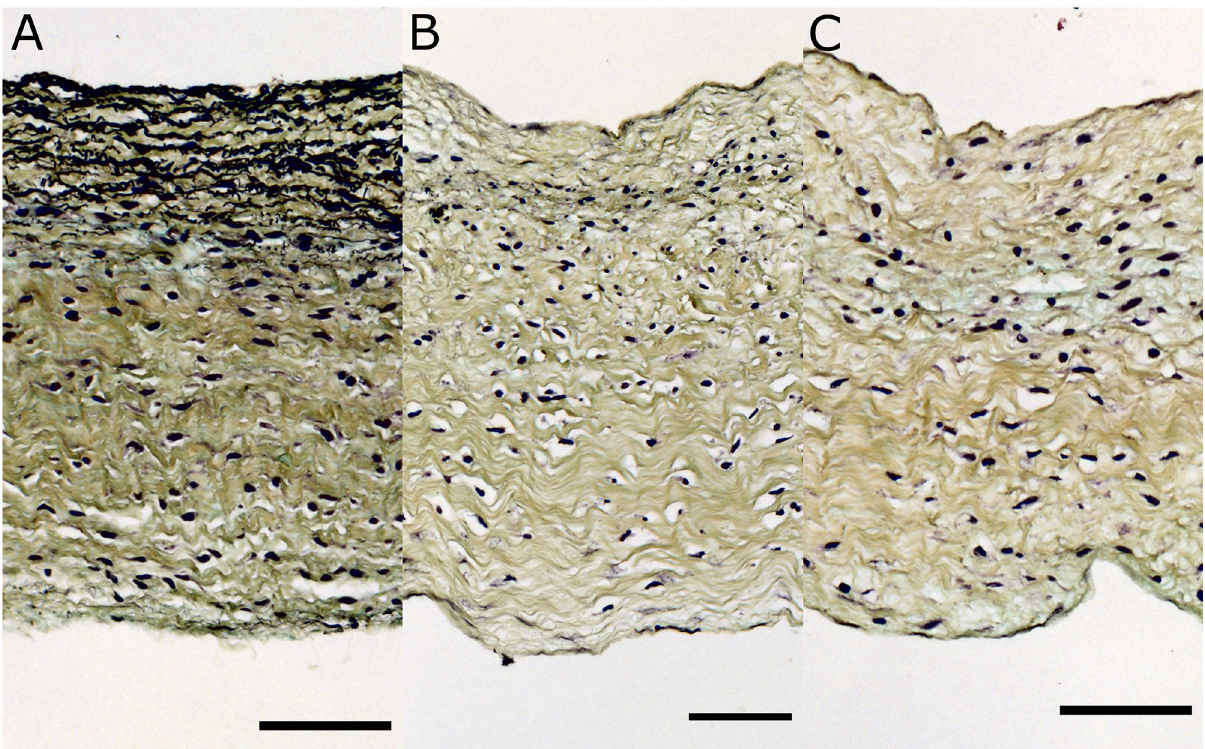
Fig 10. Cross-sectional view of a representative TV anterior leaflet along the thickness: (A) Control, (B) 10-minute elastase digestion, and (C) 20-minute digestion. After Movat Pentachrome staining, the elastin fibers are stained black while the collagen fibers are yellow. The nuclei of the valve interstitial cells (unrelated to this study) are also black. Scale bar represents 75 μm